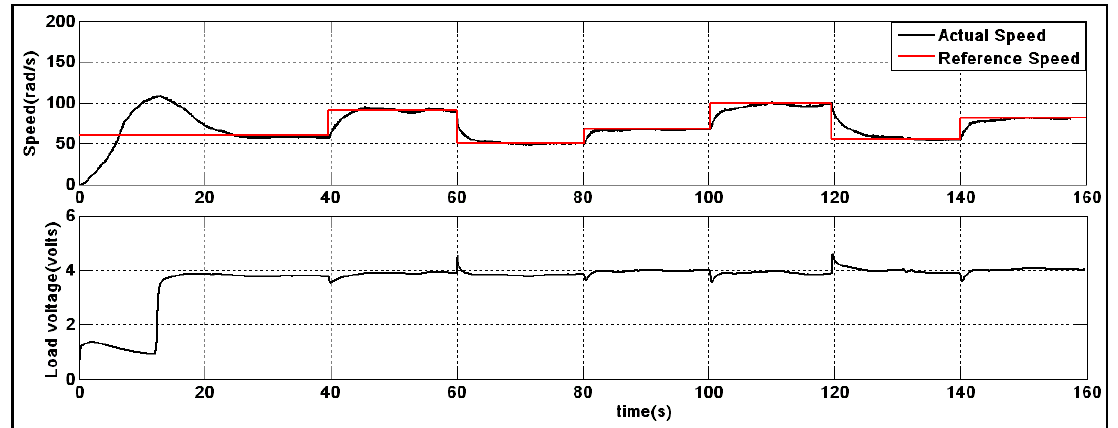
Figure 8. Speed tracking and load voltage under the adaptive SMC system. Energies 2018 , 11 , x